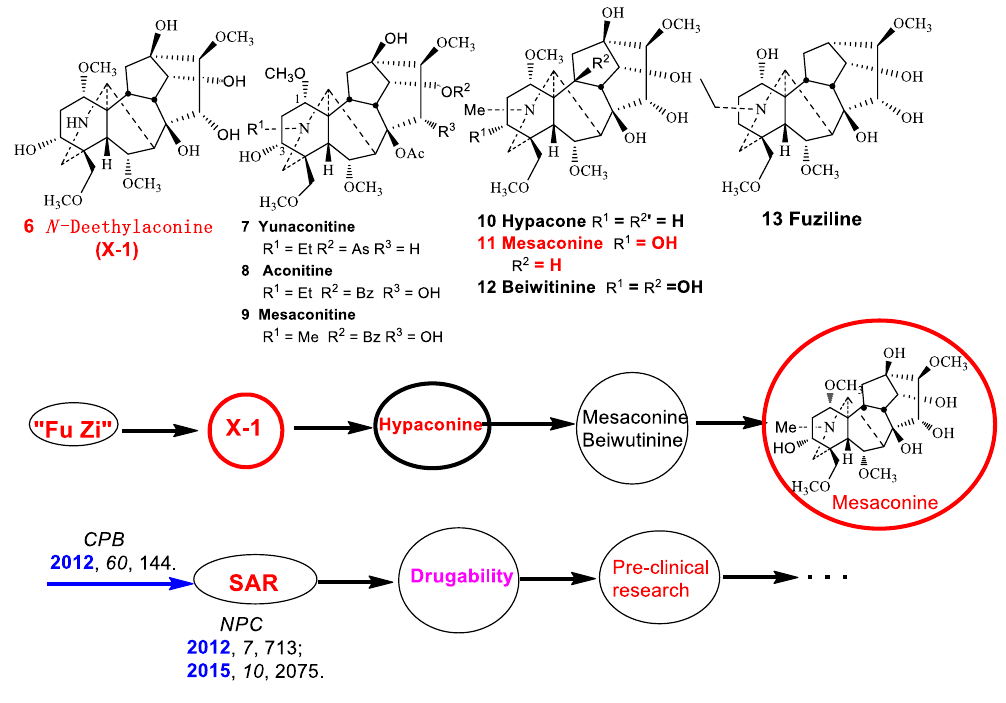
Fig. 3 Discovery, research, and development of cardiotonic component mesaconine ( 11 ) from “Fu